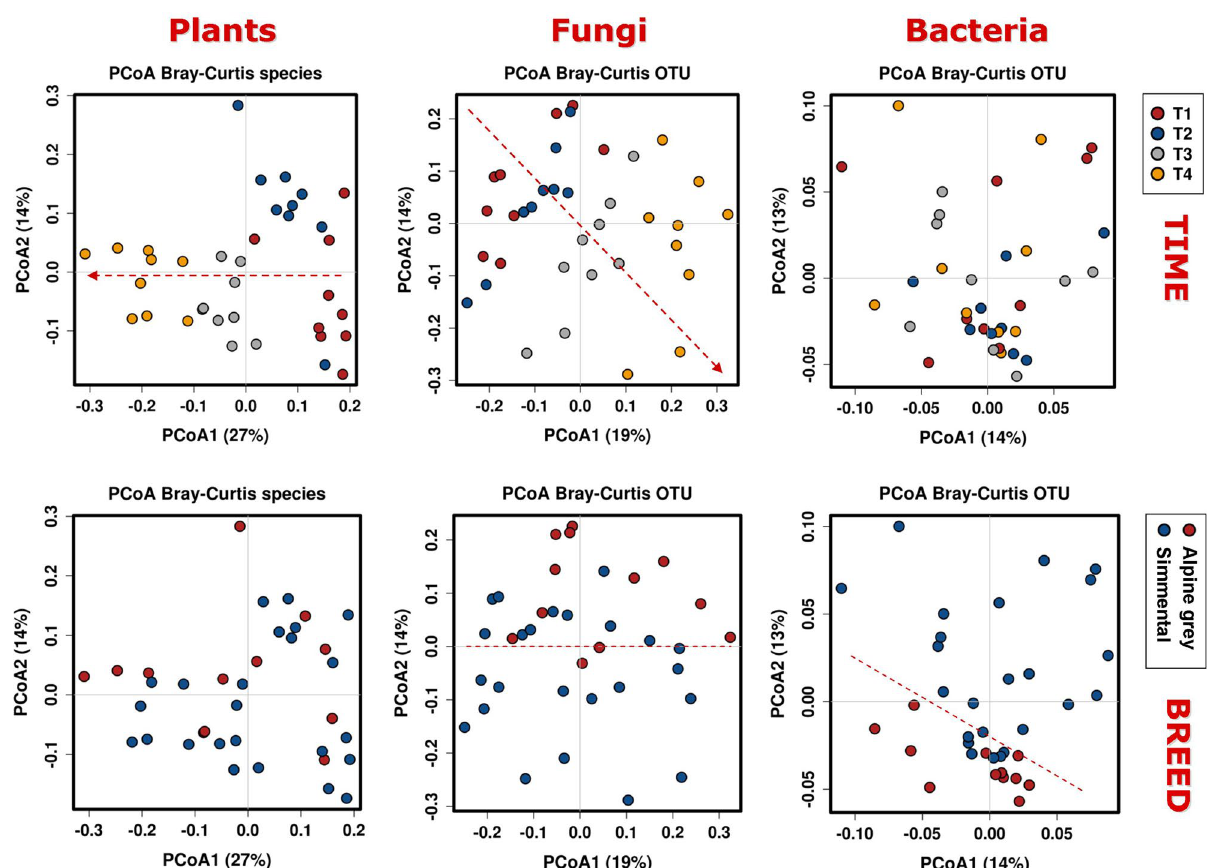
Figure 3. Principal coordinate analysis showing synoptically the ordination plots of standardized relative abundances of plant, fungal and bacterial taxa for the variables “collection time” and “breed”. Dotted arrows indicate gradients of time-consistent data partitioning. Dotted lines divide parts of the quadrants fitting a breed- consistent